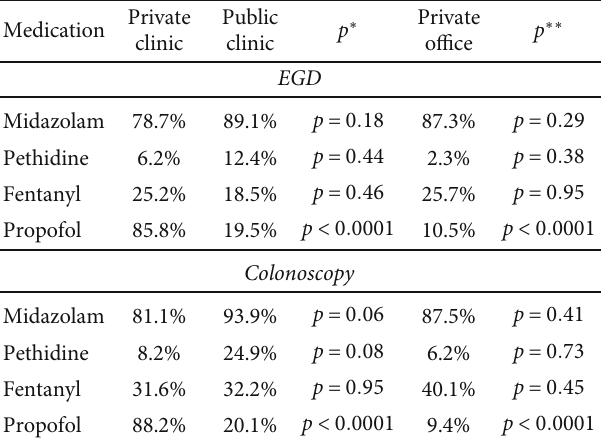
Table 3: Comparison of sedative/analgesic agents ’ use between private o ffi ce and hospital-based (private and public) settings when workload > 75 %